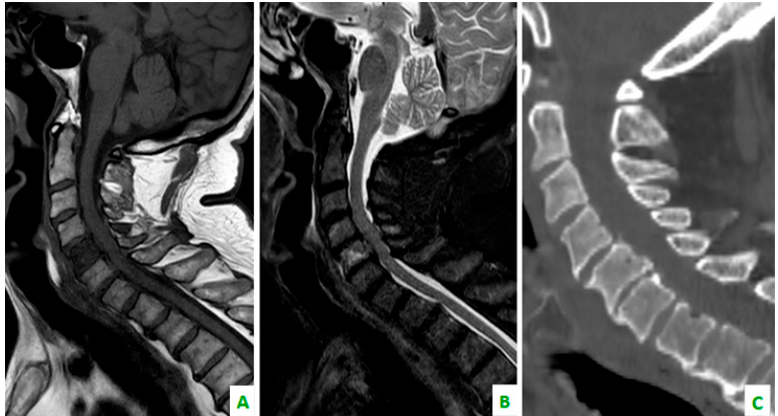
Figure 5. ( A ) A T1 sequence and ( B ) STIR sequence, performed with a dedicated spinal MRI, highlight the lung metastases. ( C ) Cervical spine on a sagittal reconstruction of a computed tomography (CT). The bone metastasis is not so clear.